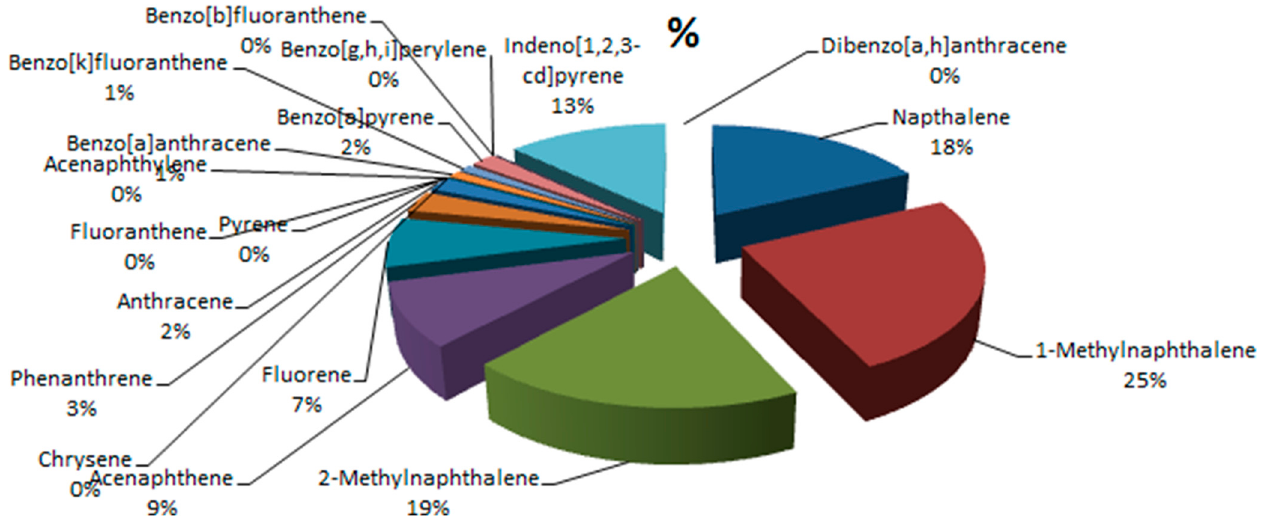
Figure 10. Percentage concentrations of the PAHs in the fish sample.